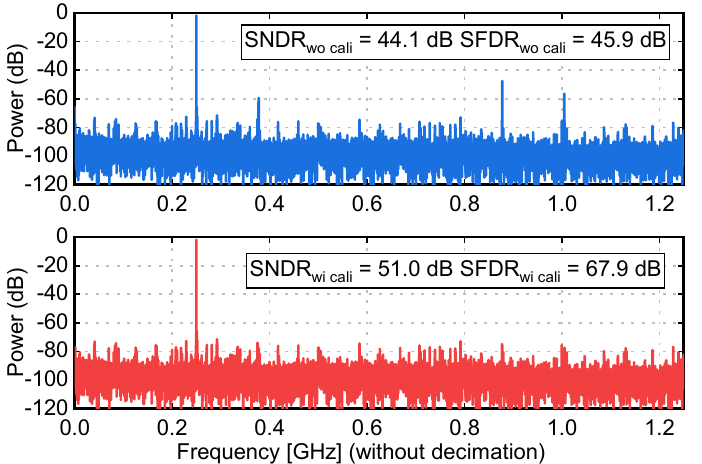
Figure 12. Measured output spectrum for a low-frequency input with and without channel mismatch calibration @ 2.5